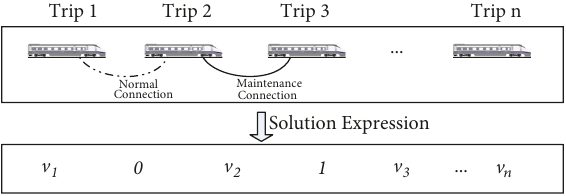
Figure 3: Coding and solution expression of GA chromosomes.